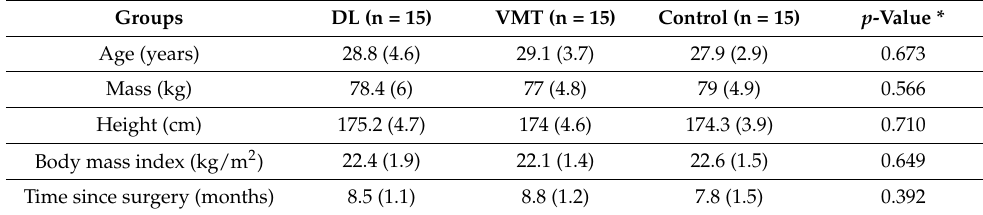
Table 1. Mean (SD) of groups’ demographic